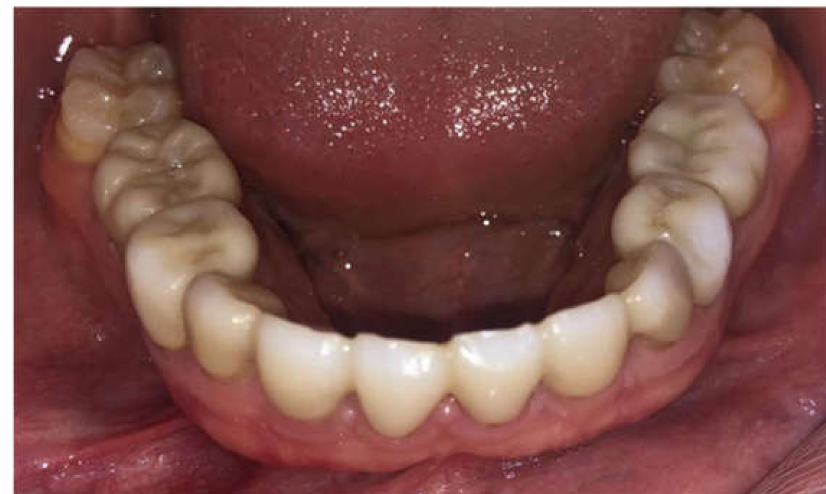
Figure 9. Porcelain teeth restoration 45–35. 60 months’ follow-up.